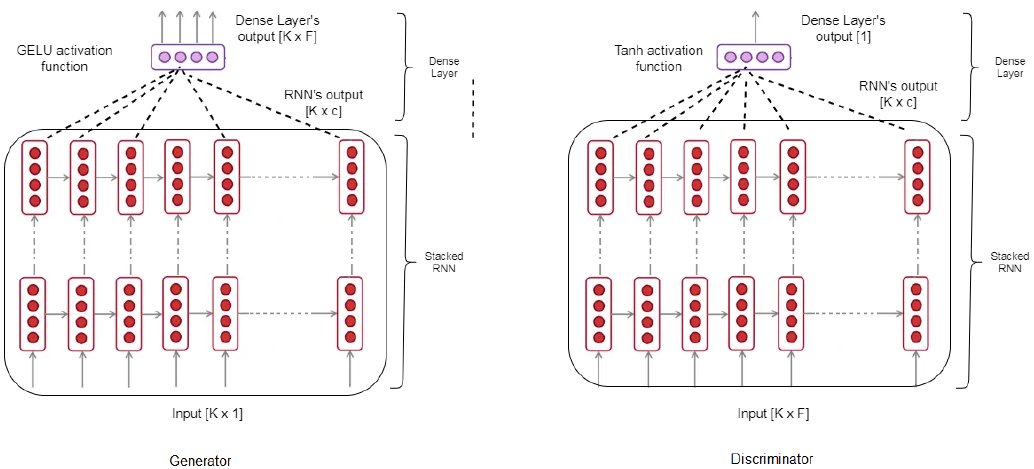
Figure 5. Recurrent GAN (R-GAN) generator and